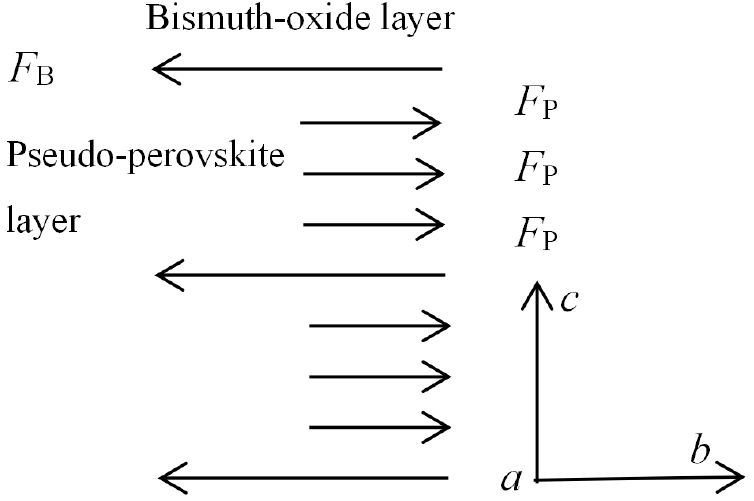
Figure 6. An analytic model for the plane stress distribution in the crystal lattice of Bi 4 Ti 3 O 12.